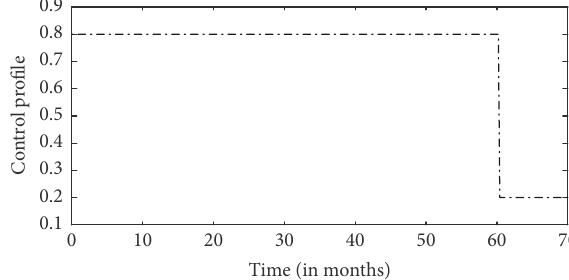
Figure 5: The control profile.